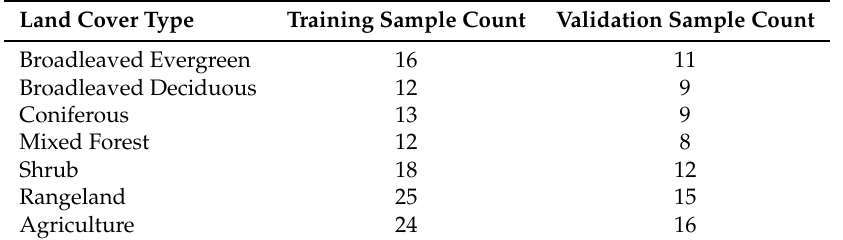
Table 4. Distribution of training and validation samples over the different land cover types.